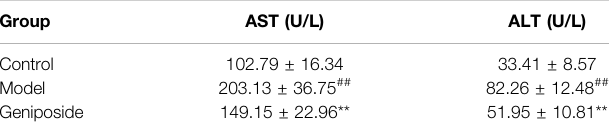
TABLE 2 | Effects of geniposide ALT and AST levels in serum.